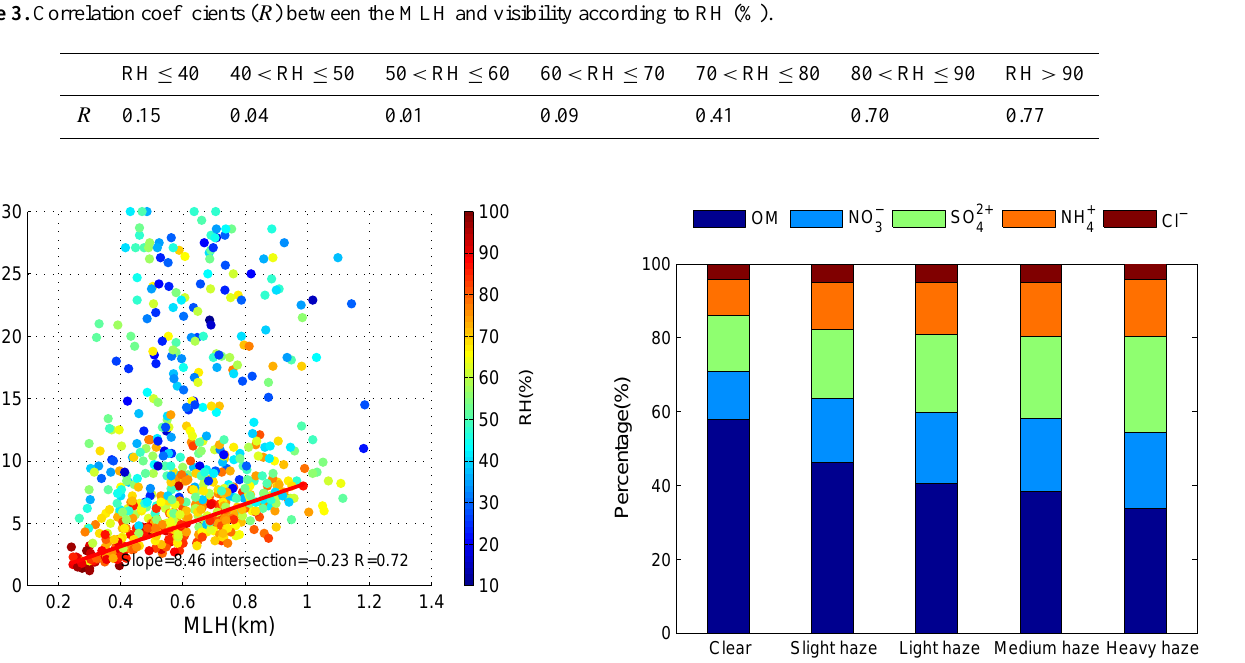
− , SO 2 + , NH + and Cl − in 3 4 4